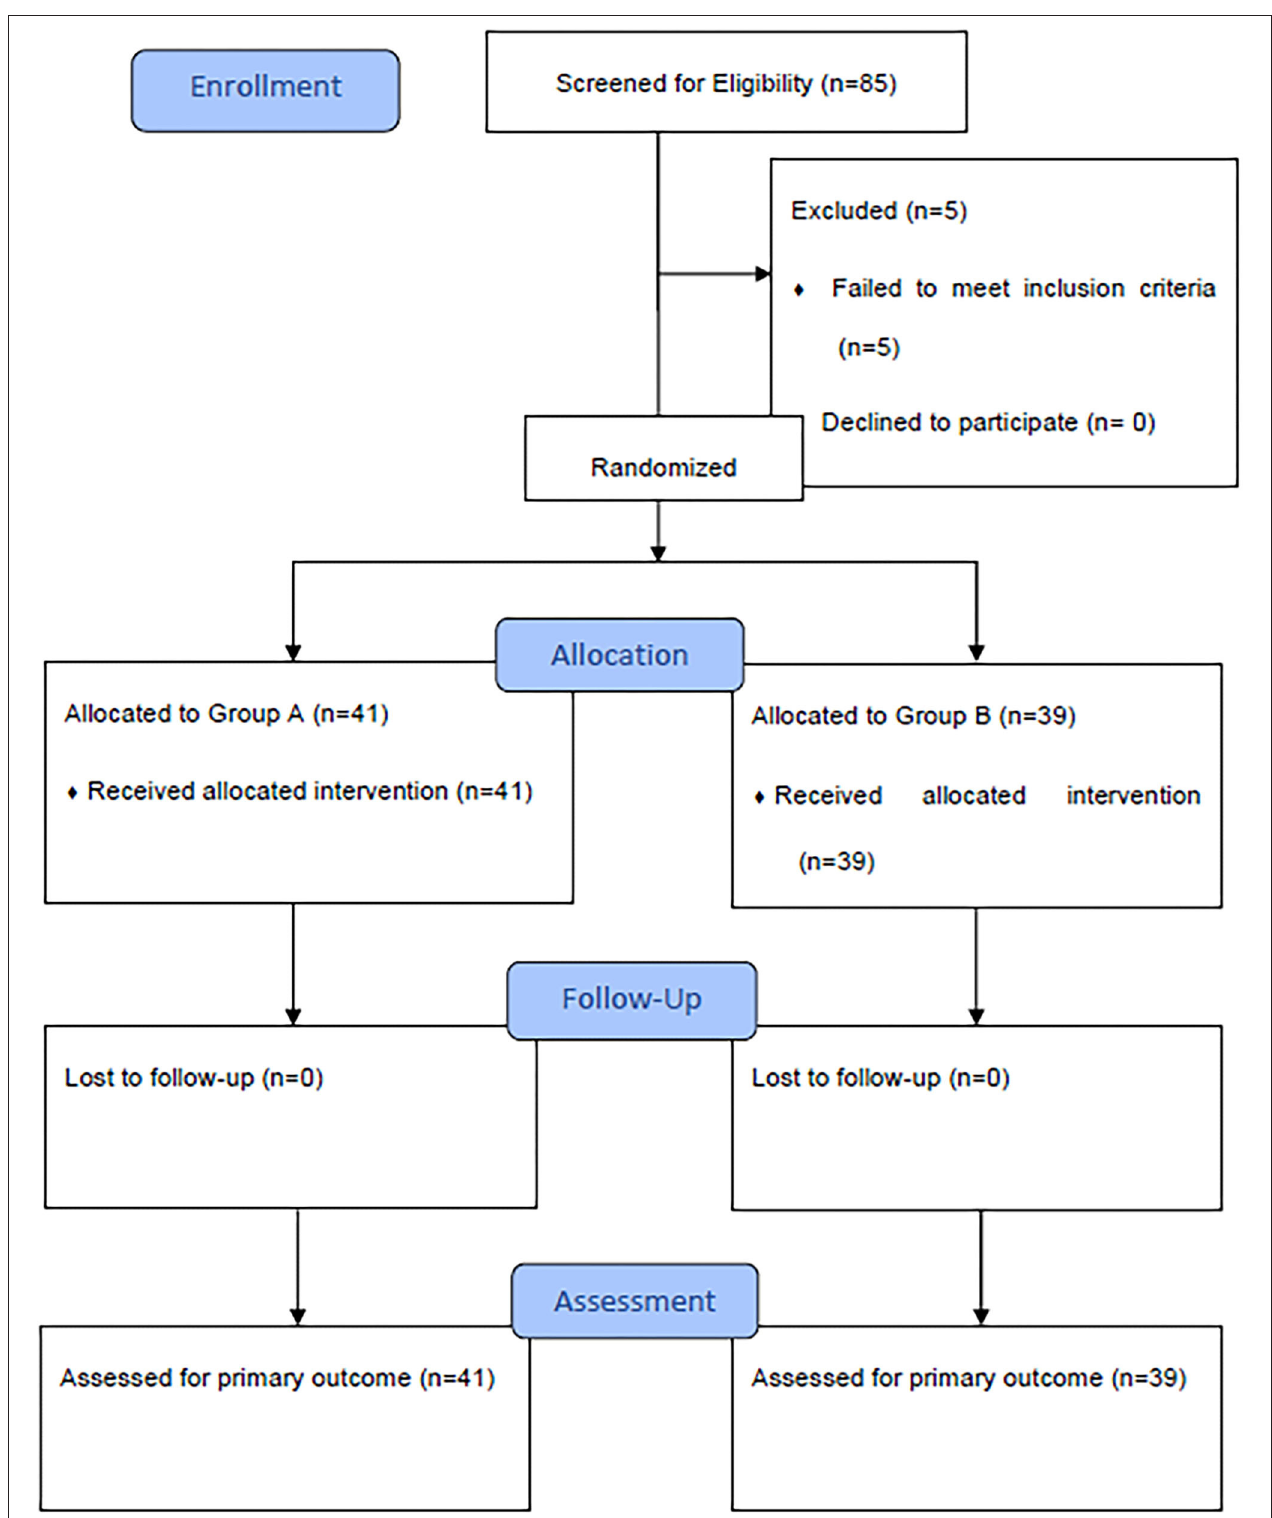
FIGURE 1 | Comparison Between nylon and polyglactin corneal sutures in pediatric cataract surgery: CONSORT flow diagram.